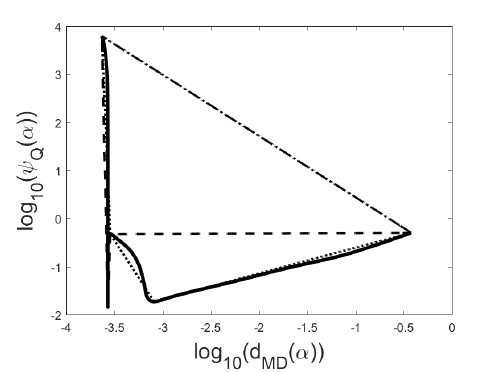
Figure 10. Q-curve, problem Heat, n =